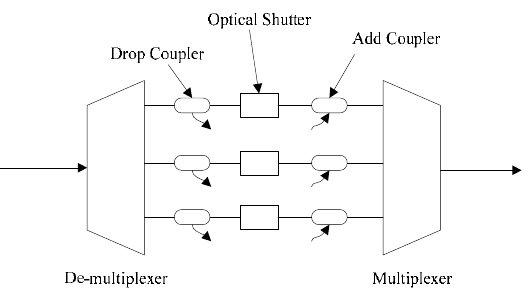
Fig. 1. The node architecture of